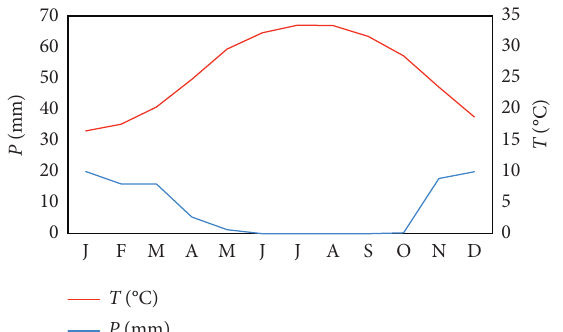
Figure 2: Bagnouls and Gaussen’s ombrothermic diagram for Bahrain